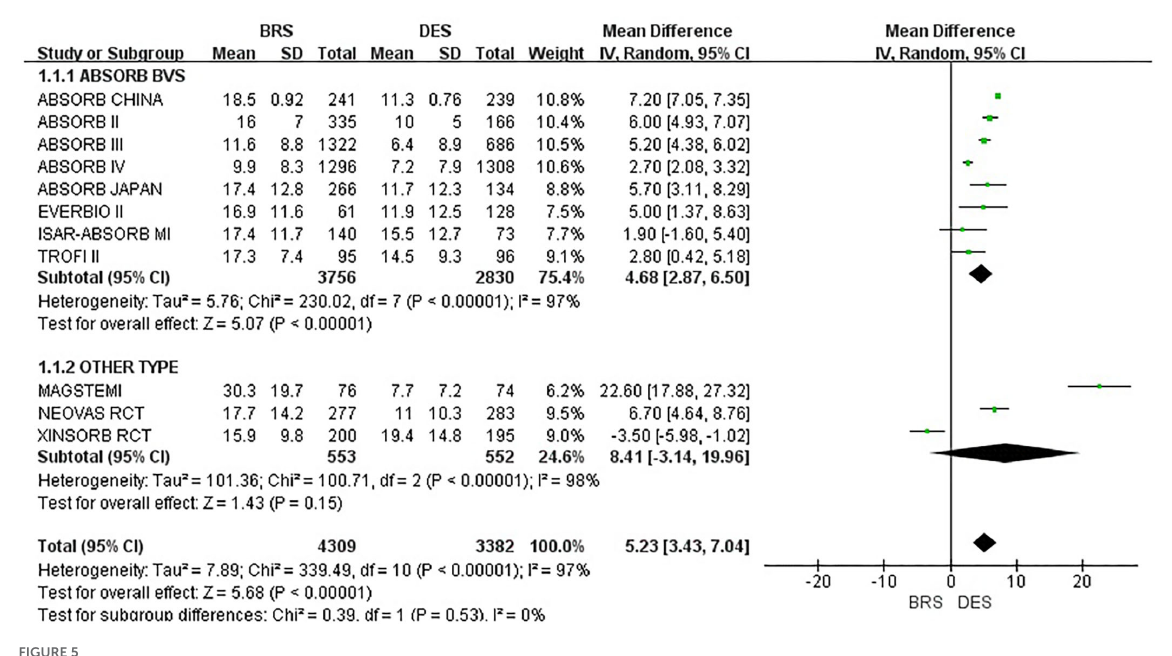
FIGURE5 Meta-analysis results of forest plots for in-stent